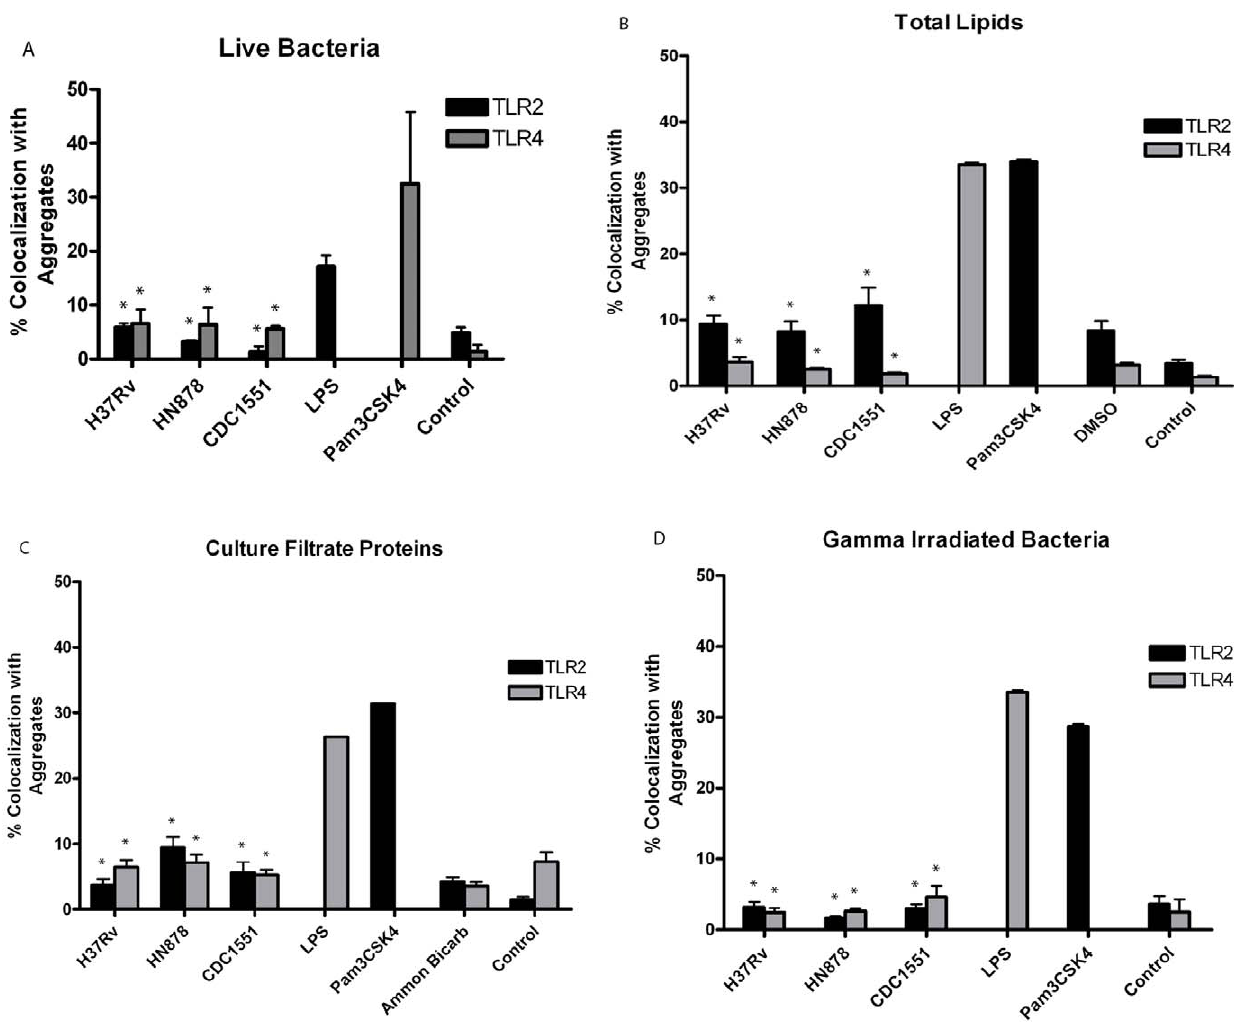
Figure 7. TLR-2 and TLR-4 do not colocalize with LR aggregates after infection/treatment with Mtb bacilli or cell fractions. A549 cells were infected with live Mtb strains CDC1551, HN878 or H37Rv at MOI 100 or treated with total lipids (TL), culture filtrate proteins (CFP) and gamma- irradiated cells for 24 hr, as described. Colocalization of anti-TLR-2 and anti-TLR-4 antibodies with LR aggregates was analyzed from confocal images using Manders coefficient values. Infections with CDC1551, HN878 and H37Rv produced significantly less TLR-2 and TLR-4 colocalization compared to positive controls (*p-value , 0.001) (A). There were no significant differences between TL-treated cells and DMSO controls at this time point (B) (TLR-4, p-value=0.532 to 0.983; TLR-2, p-value=0.775 to 1.0). TLR-2 and TLR-4 colocalization for controls and CFP-treated cells was comparable (C). At 24 hr post-TL (B) and –CFP (C) treatment, colocalization of receptors was significantly decreased compared to positive controls (*p-value , 0.001). These findings also held true for epithelial cells infected with gamma-irradiated bacteria from all three strains (*p-value , 0.001) (D). Images were collected at 63x magnification and analyzed using ImageJ JACoP plugin. Infections were performed in duplicate and repeated three times.